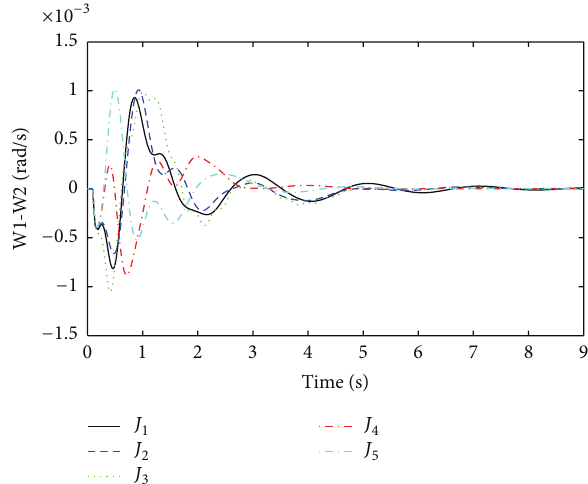
Figure 5: Local mode of oscillations between G1 and G2 (W1-W2) for three-phase fault at bus